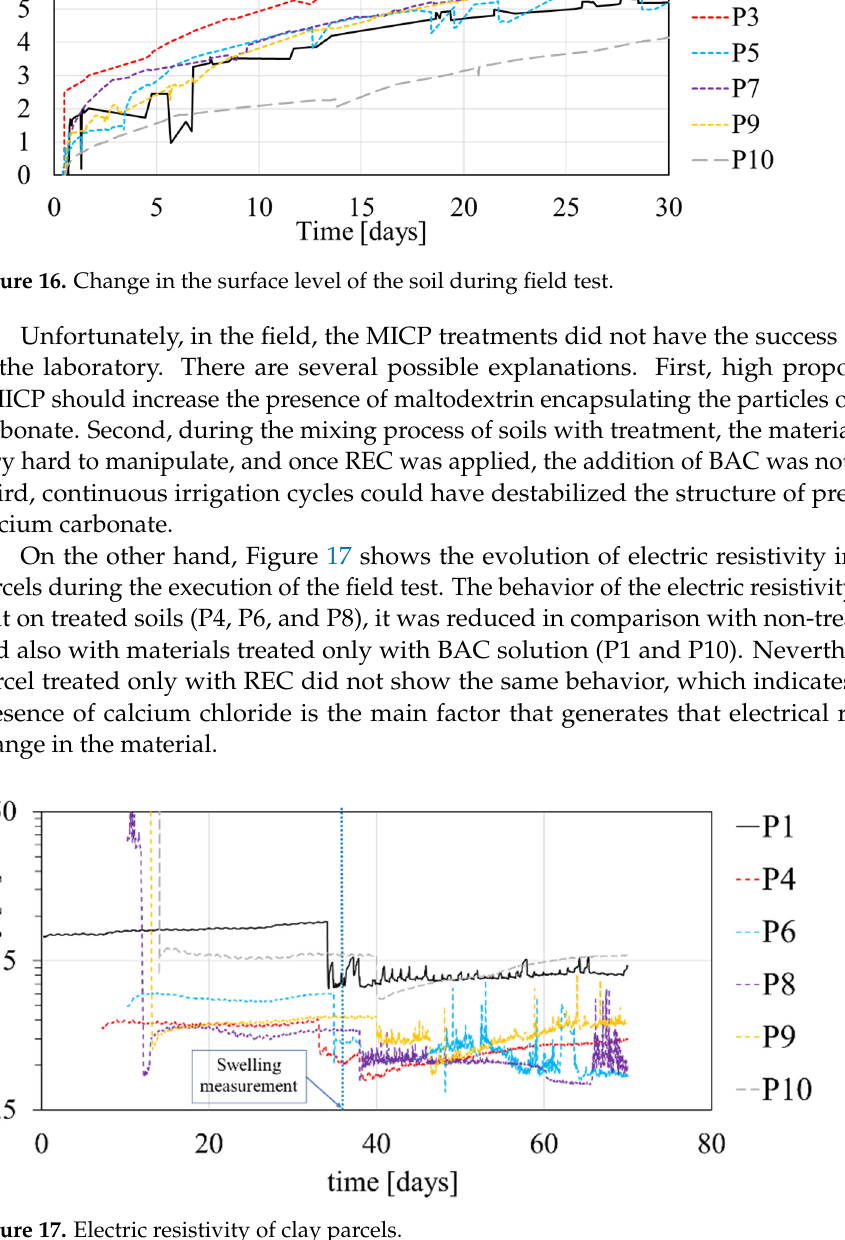
Figure 17. Electric resistivity of clay